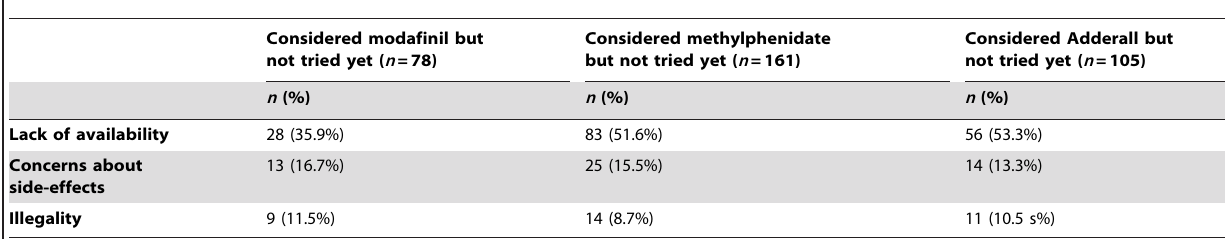
Table 7. Reasons for not using by those who have considered a PCE.